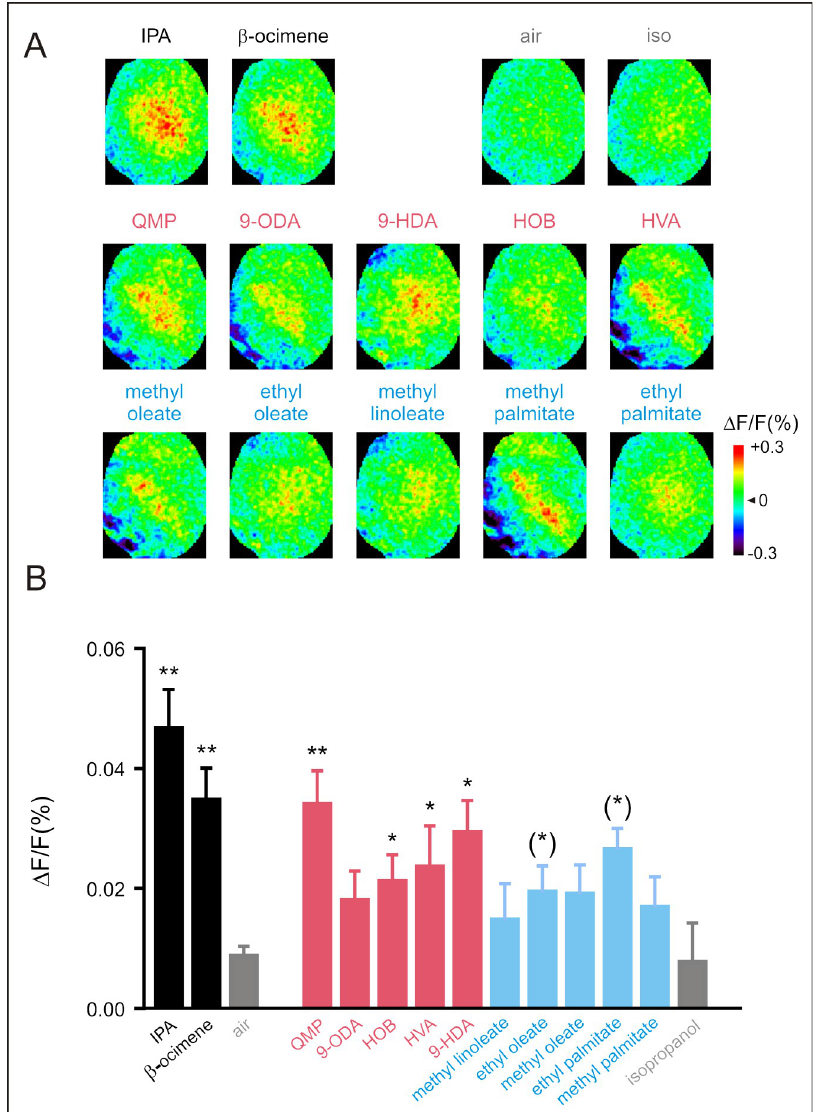
Fig 6. Neural responses to pheromonal odorants recorded in the LH. ( A ) GCaMP6f calcium signals in the LH evoked by a panel of pheromonal compounds, both volatile (IPA and ocimene in black) or not volatile (queen pheromone compounds in red and brood pheromone compounds in blue) and to the controls (isopropanol and air). Different odorants induce different activity patterns. Relative fluorescence changes ( Δ F / F [%]) are presented in a false- color code (see colorbar), from dark blue (minimal response) to red (maximal response). ( B ) Amplitude of calcium responses ( Δ F / F [%]) to the 12 tested odorants and to the controls (air and isopropanol). Volatile odorants and queen pheromone compounds induce significant activity in comparison to the controls ( n = 7 honey bees, � p < 0.05). The data underlying the graphs shown in the figure can be found in S4 Data. LH, lateral horn. although the response intensity was significantly higher from the controls (Fig 6B, n = 7 honey bees) for volatile compounds ( t tests, t > 4.35, p < 0.005) and for queen pheromone compounds (Friedman ANOVA, odor effect F = 30.23, p = 0.0008; t tests or Wilcoxon tests, t > 2.48, 11 p < 0.05 except for 9-ODA with t = 1.8 and p = 0.11) but not for brood pheromone compounds ( t -tests t < 2.09, p = NS).